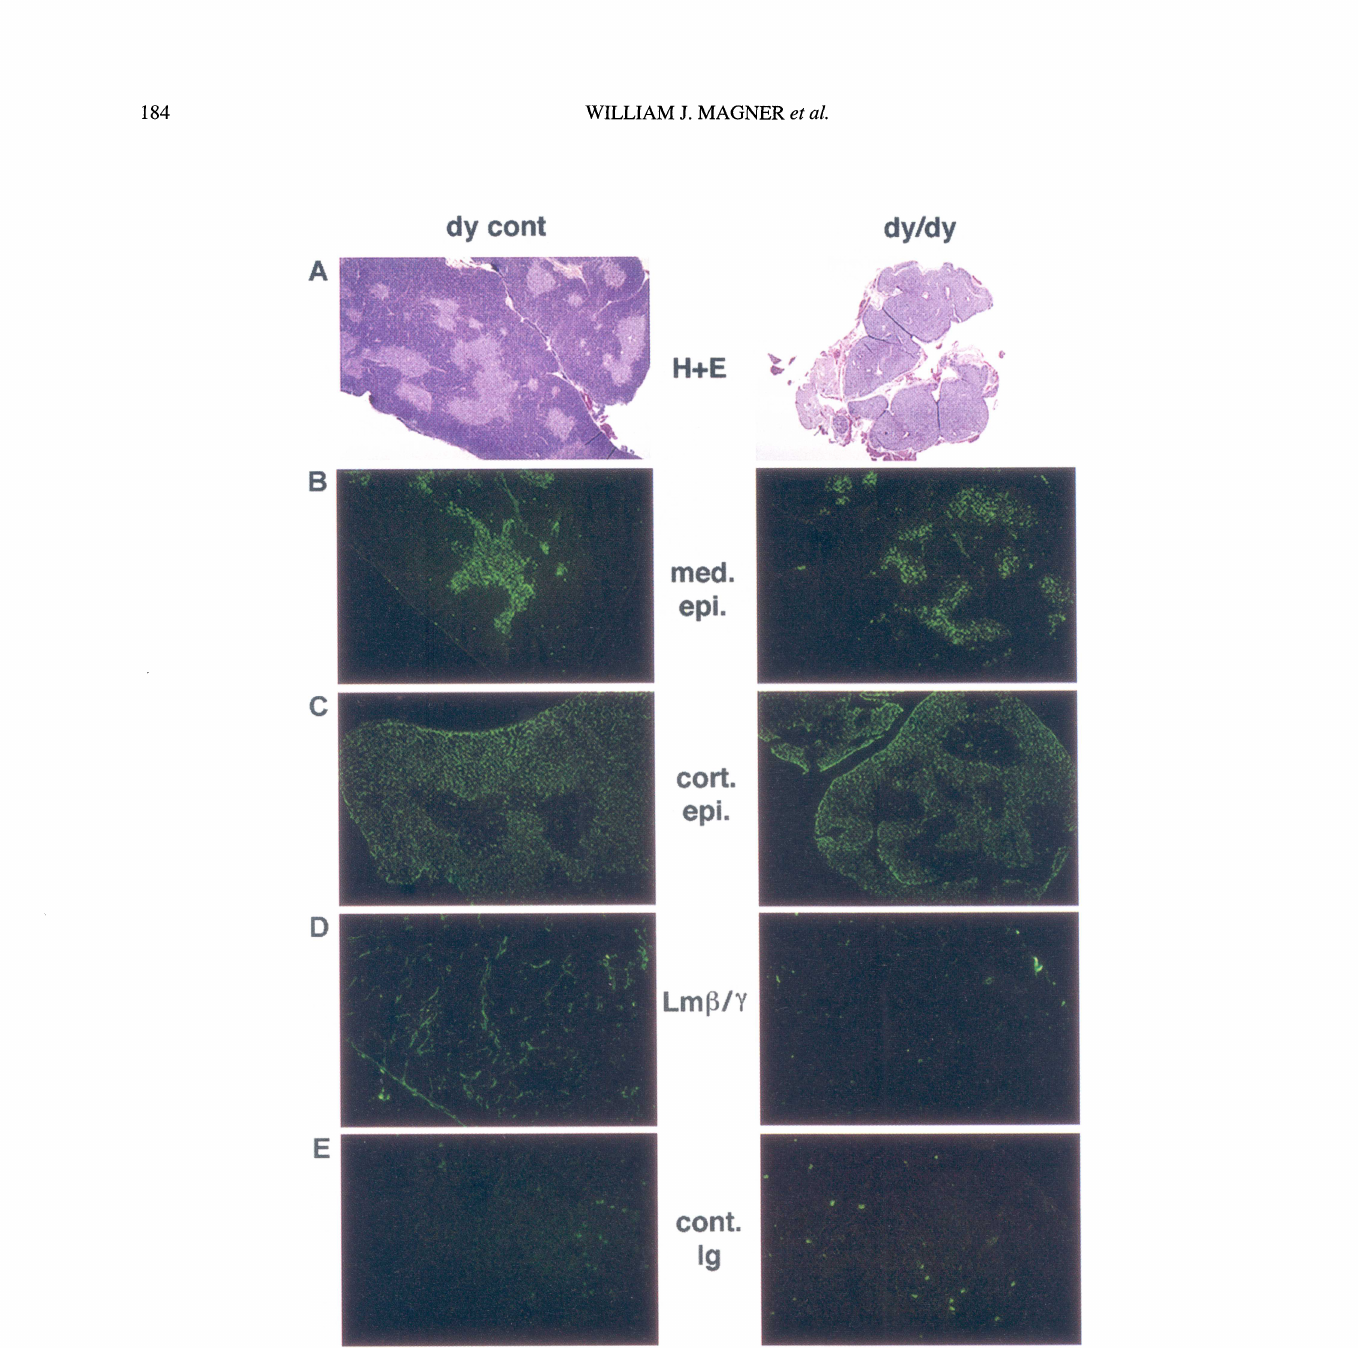
FIGURE Immunohistochemical analyses of dy/dy and dy control thymi. Panel A is shown at 25X magnification, panels B-E are 50X. A Hemotoxilin-Eosin staining of thymic sections were performed to reveal the intact thymic architecture. As stated in Table I, the dy/dy thymi are much smaller and contained fewer cells than those of control littermates. The cortex (C) and medulla (M) are clearly visible in the dy con- trol but not in the dy/dy thymus. B & C. Immunohistochemical staining for cortical and medullary epitopes. To characterize the thymic archi- tecture, thymic sections were stained with antibodies specific for cortical or medullary epithelia (4F1 and ERTR5 respectively). The cortical and medullary epithelia are clearly present but smaller or more compact in the dy/dy mice. D. Immunohistochemical staining for laminin [ and y1 chains. To examine laminin expression, thymic sections were stained with the Clone antibody which is specific for the laminin and y1 chains; these chains are common to laminin-1 and laminin-2. The dy/dy thymus is clearly deficient in laminin 1 and y1 protein expression. The antibody used is IgM, the high background appeared to be characteristic of this antibody. Despite the high background, the classic ECM network staining is not visible in the dy/dy section. E. Isotype matched negative control for Figure 1D (see Color Plate XII at the back of this